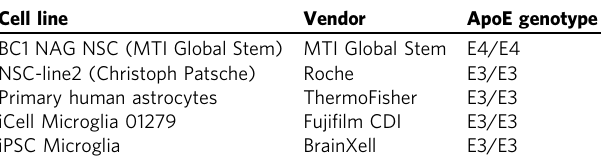
Table 1 ApoE genotype